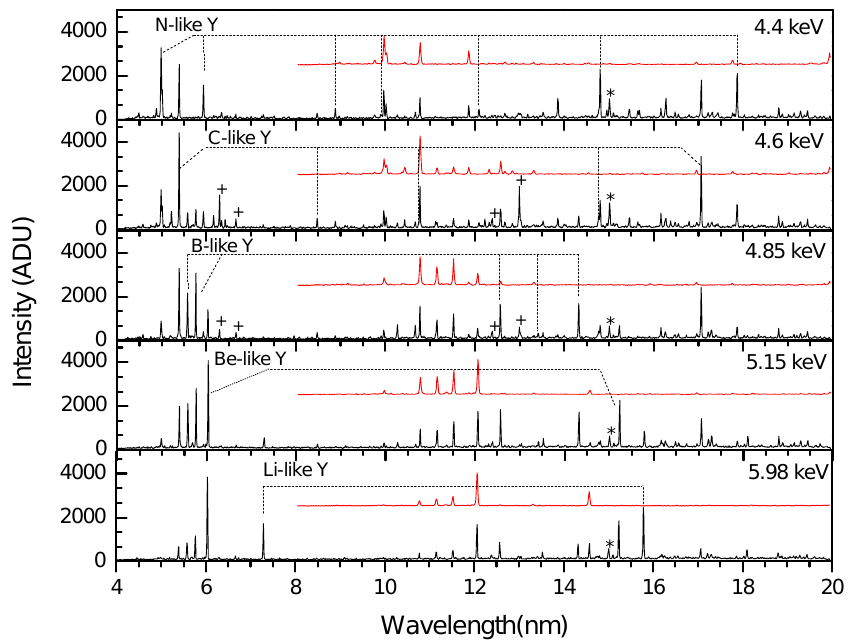
Figure 5. Yttrium spectra at beam energies from 4.40 keV–5.98 keV. The black and red (shifted) spectra correspond to the first and second order Y spectra, respectively. The + marks the Na-like and Mg-like xenon impurities at beam energies of 4.6 keV and 4.85 keV and the ∗ marks the impurity coming from oxygen at 15.0099(5)